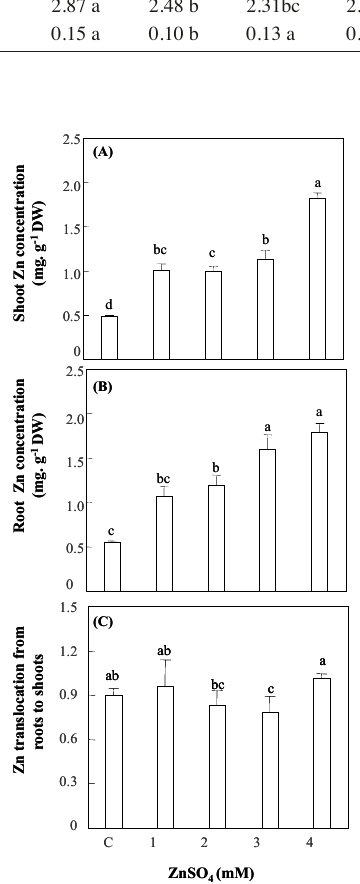
Fig. 4: Shoot Zn concentration (A), root Zn concentration (B) and Zn trans- location factor (C) of fenugreek plants grown with different ZnSO 4 concentrations for 52 days. Values (means ± SE of three replicates) followed by the same letter are not significantly different (Duncan test, P =